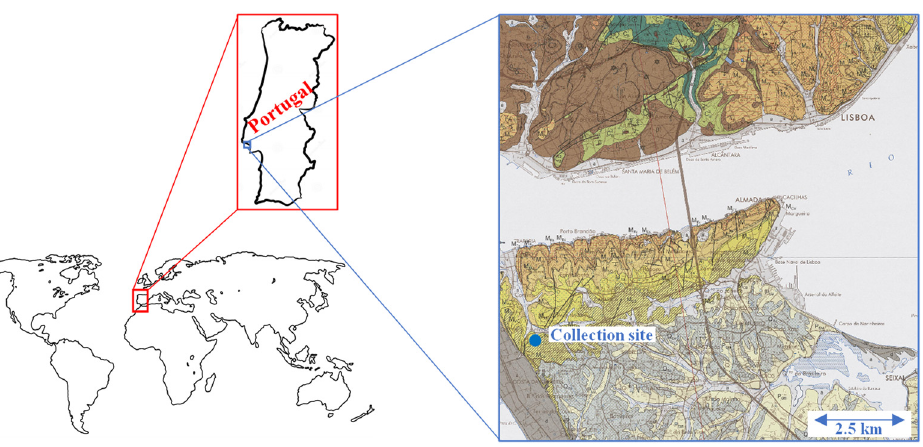
Figure 2. Identification of the collection site on different scales (world; country; local site on an extract of the Geological Map of Portugal, 34-D sheet [24]).